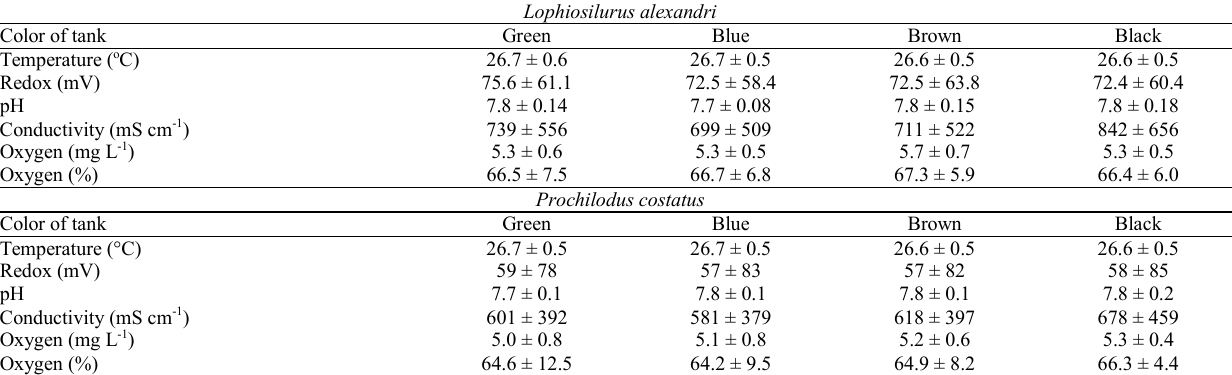
Table 2. Average values (± standard deviation) of water quality parameters of cultivation of the larvae of pacamã ( Lophiosilurus alexandri ) and curimatá-pioa ( Prochilodus costatus ) in tanks of four different colors, for 10 days. Averages in the same row did not differ (P>0.05) significantly by Tukey’s